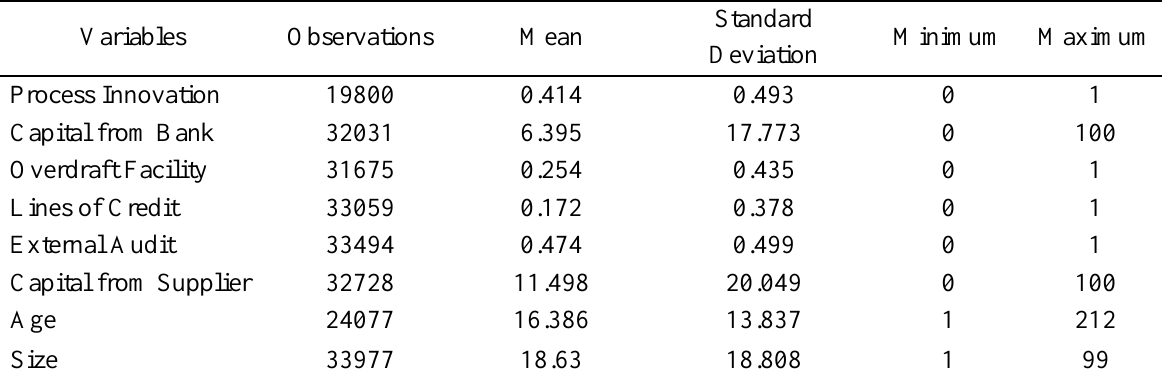
Table 2. Descriptive statistics of dependent and independent variables